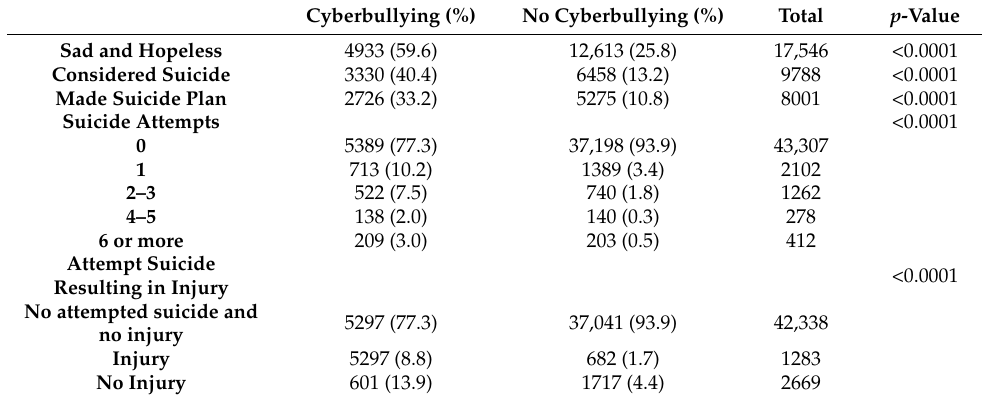
Table 2. Univariable analysis showing association of cyberbullying with mental health outcomes.